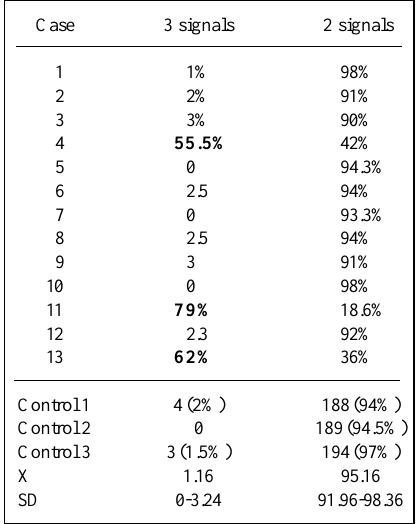
Table II - Results of FISH analysis.